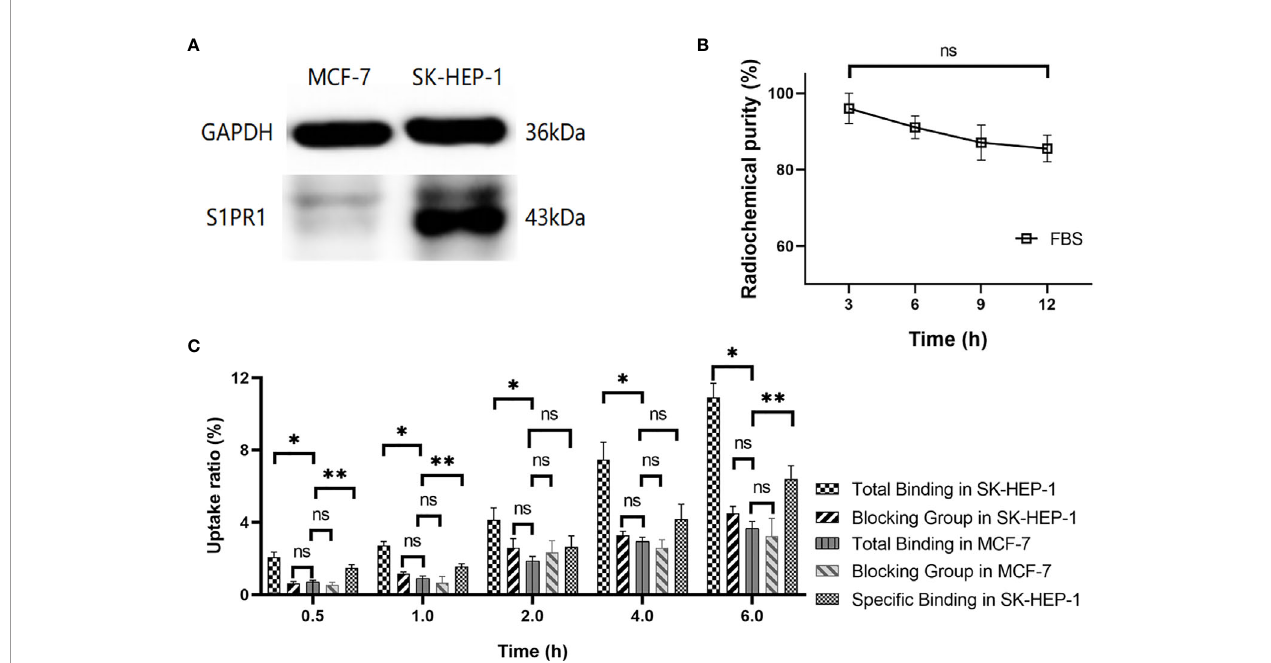
FIGURE 1 | (A) Western blot analysis of S1PR1 expression in SK-HEP-1 cells and MCF-7 cells; (B) Stability of 99m Tc-HYNIC-S1PR1mAb in vitro at 3h, 6h, 9h, 12h in FBS; (C) In vitro cellular uptake. The total bindings and blocking results of 99 mTc-HYNIC-S1PR1mAb in SK-HEP-1 cells (experiment group) and MCF-7 cells (control group) were included in panel C, as well as the speci fi c binding in SK-HEP-1 cells. There was no signi fi cant difference between the blocking and non- blocking in MCF-7 cells. *, **, and ns indicate P < 0.05 and P > 0.05 (n = 4),